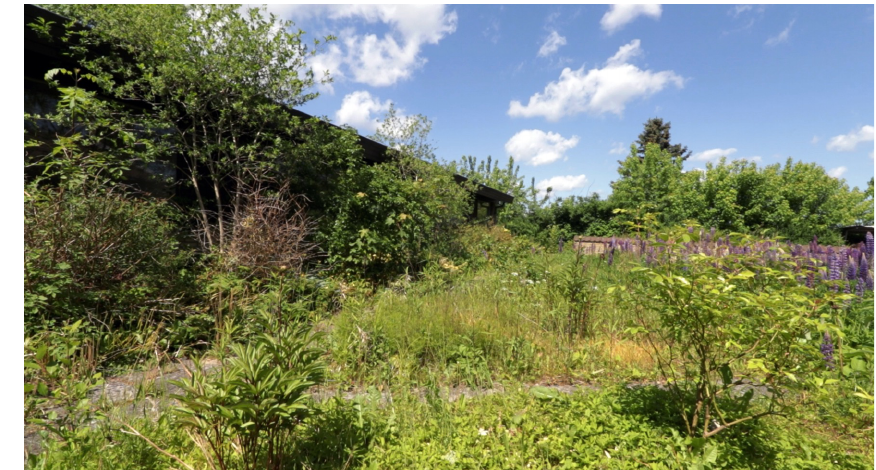
Figure 4. Plants slowly overtaking one of the unused areas belonging to the retirement home. June 2017.